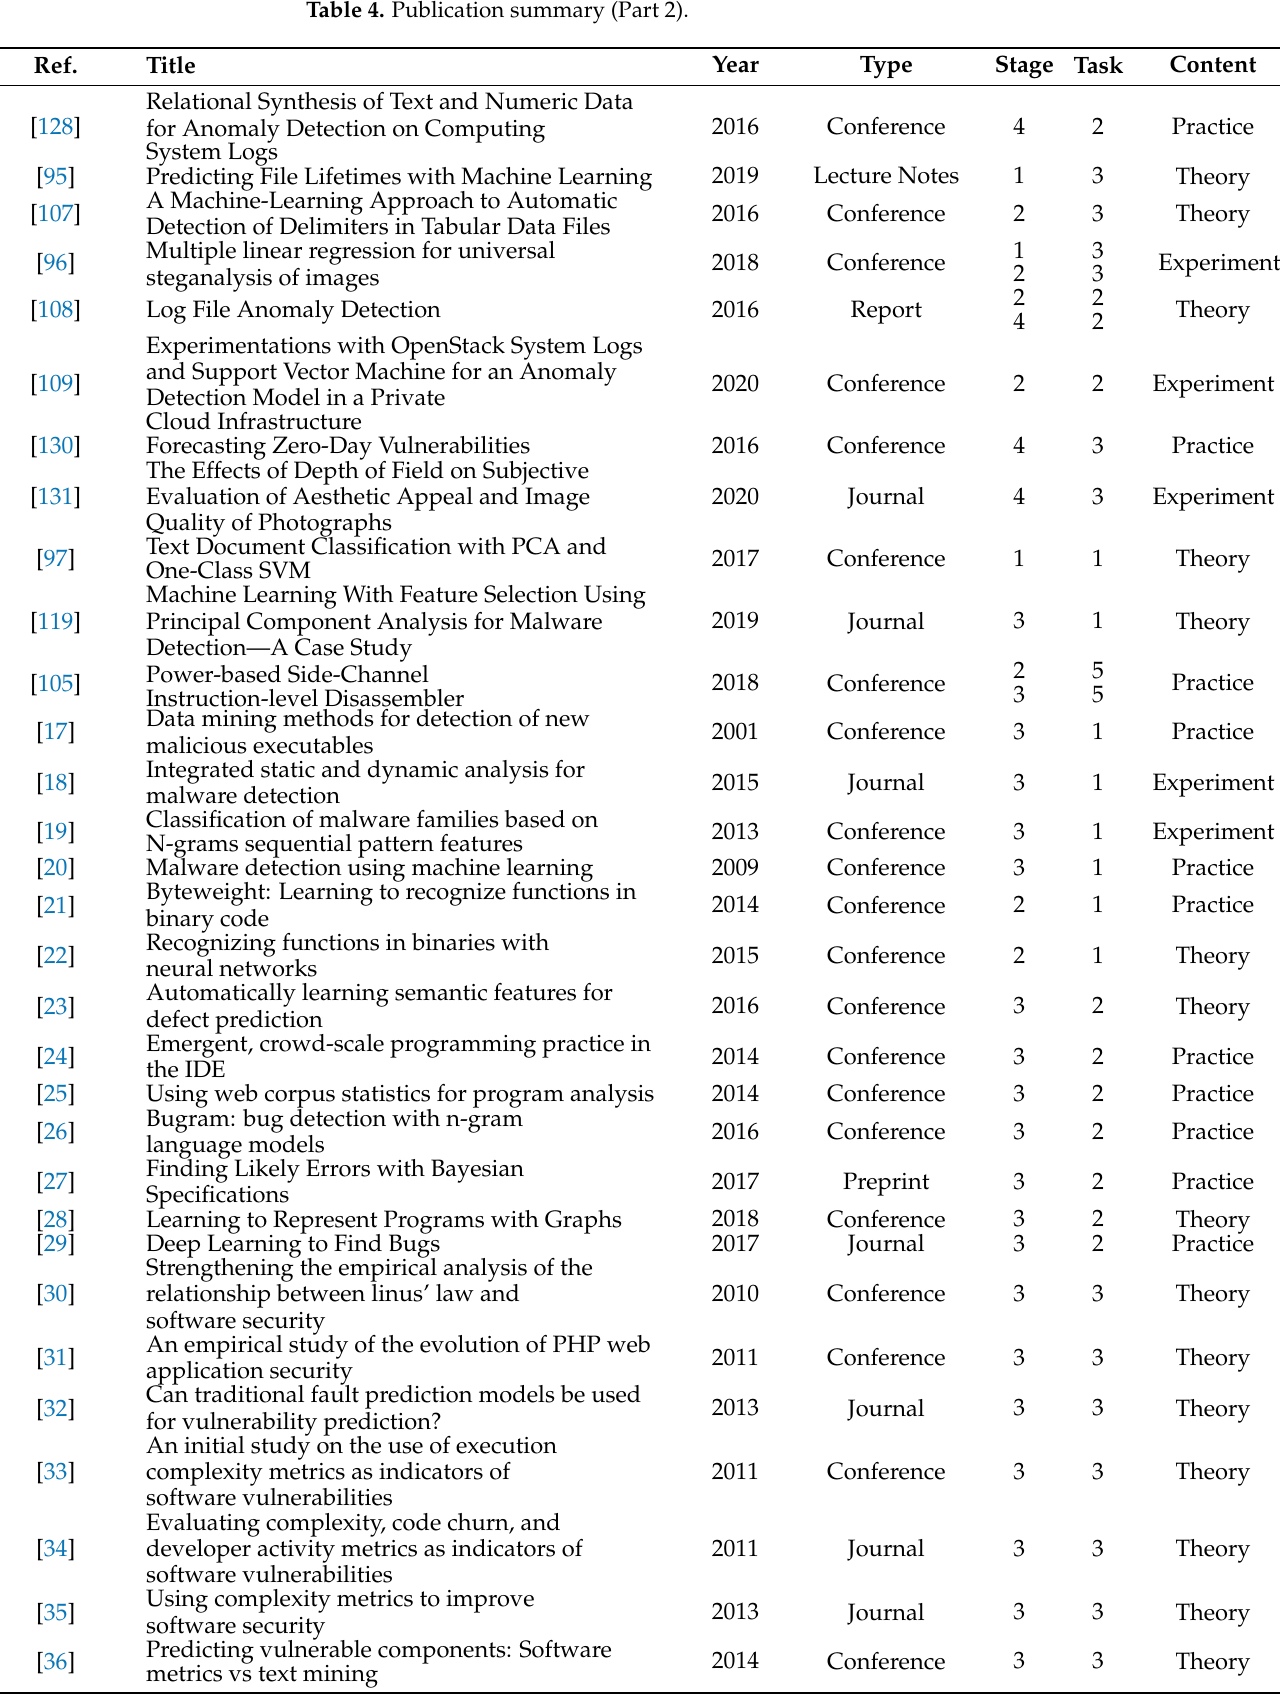
Table 4. Publication summary (Part 2).